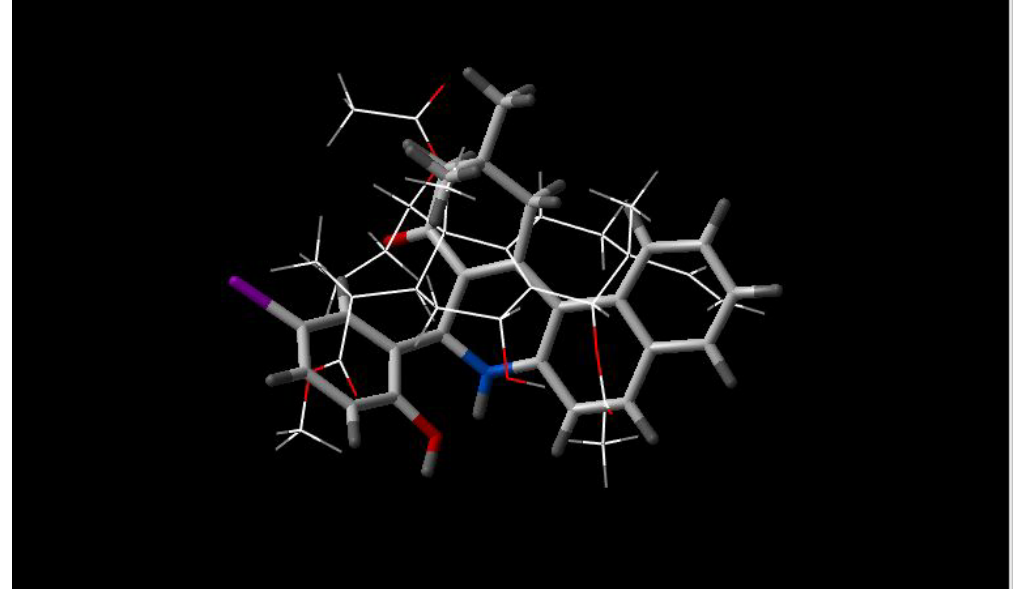
Figure 8. Best fit of optimised INF277 (sticks) and diterpene from Lycopus europaeus (wireframe) structures.